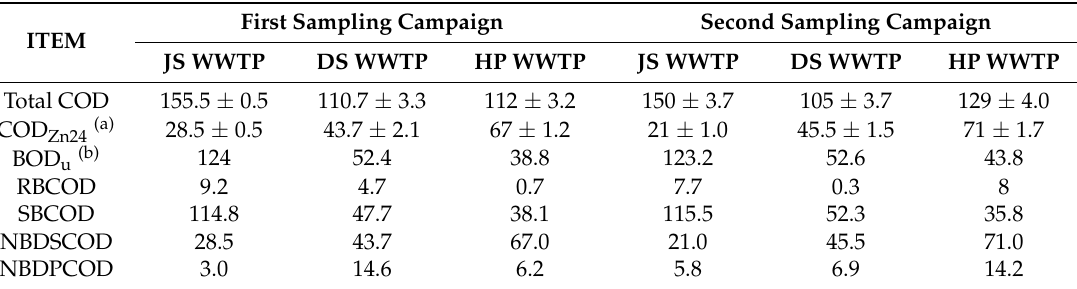
Table 1. Summarized results of the COD fractionation tests carried out for the two sampling campaigns from October to November